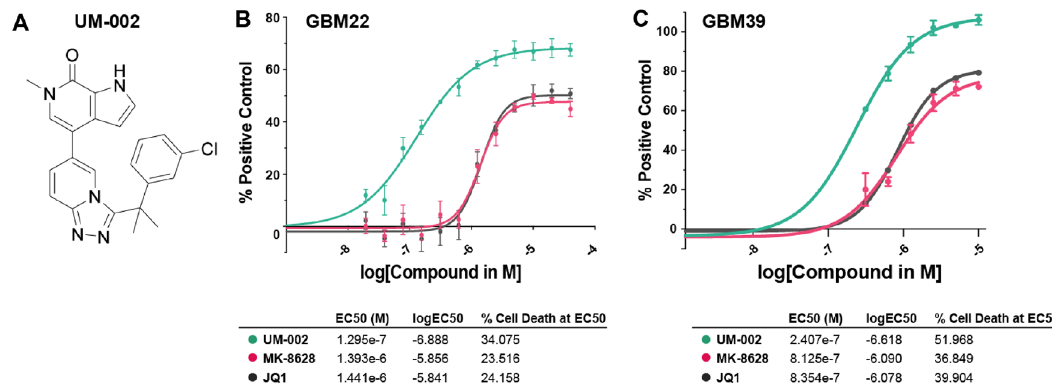
Figure 1. UM-002 reduces GBM cell proliferation in vitro. ( A ) Structure of UM-002. ( B,C ) UM-002 is more potent than JQ1 or MK-8628 in reducing GBM cell proliferation in vitro. GBM22 cells ( B ) or GBM39 cells ( C ) were treated with UM-002, MK-8628, or JQ1, starting at a dose of 10 µM, with 1:2 serial dilutions. Reduction in ATP levels was measured using CellTiter-Glo after 72 h of compound treatment and luminescence was normalized to the positive control. Dose response curves were calculated using a variable slope (4 parameters) fit. EC 50 and the percentage of positive control at EC 50 was calculated for each